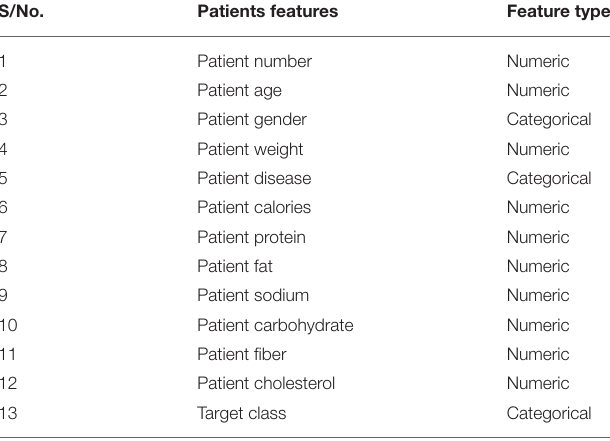
TABLE 2 | Features of patients. S/No.